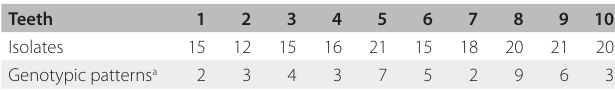
Table 2 - Total of S. mutans strains and genotypic patterns found in each tooth from all collects (A, B and